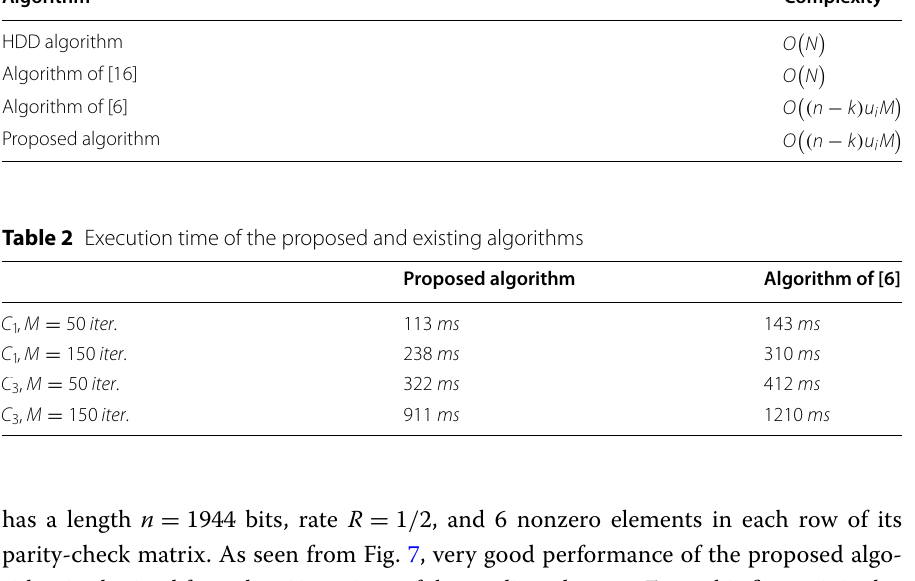
Table 1 Order of complexity in terms of number of multiplications Algorithm Complexity HDD algorithm